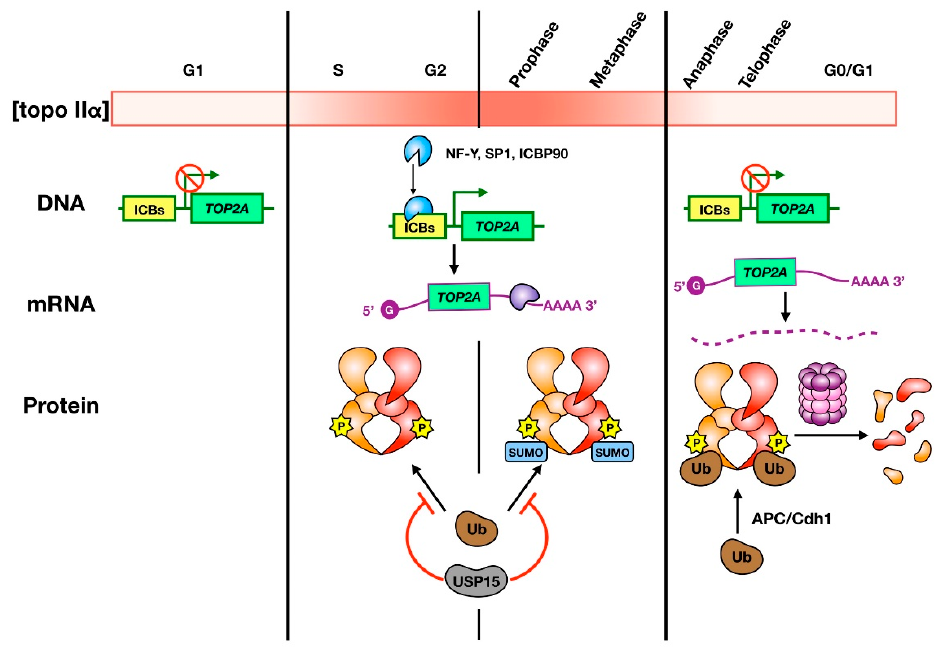
Figure 1. Regulation of topo II α abundance during the cell cycle. The color gradient bar indicates how levels of topo II α vary from low (white) to high (red) in different cell cycle stages. The cartoon depicts the current understanding of how topo II α transcription (DNA), translation (mRNA), and stability (protein) are regulated. Transcription of topo II α occurs in S phase, through to mitosis, and is regulated by transcription factor binding to ICBs in the promoter region of the TOP2A gene. Translation is controlled by cell cycle-dependent mRNA stability, and potentially by cell cycle-dependent proteins that bind and stabilize the 3 (cid:48) -UTR. Topo II α protein is protected from ubiquitin-mediated degradation during S phase through metaphase by the deubiquitylase USP15. Cell cycle-dependent phosphorylation also occurs from S phase to metaphase and SUMOylation occurs upon entry into mitosis. SUMO modifications are lost upon anaphase onset. At this stage, topo II α is ubiquitylated by APC / Cdh1 and is subject to proteasomal